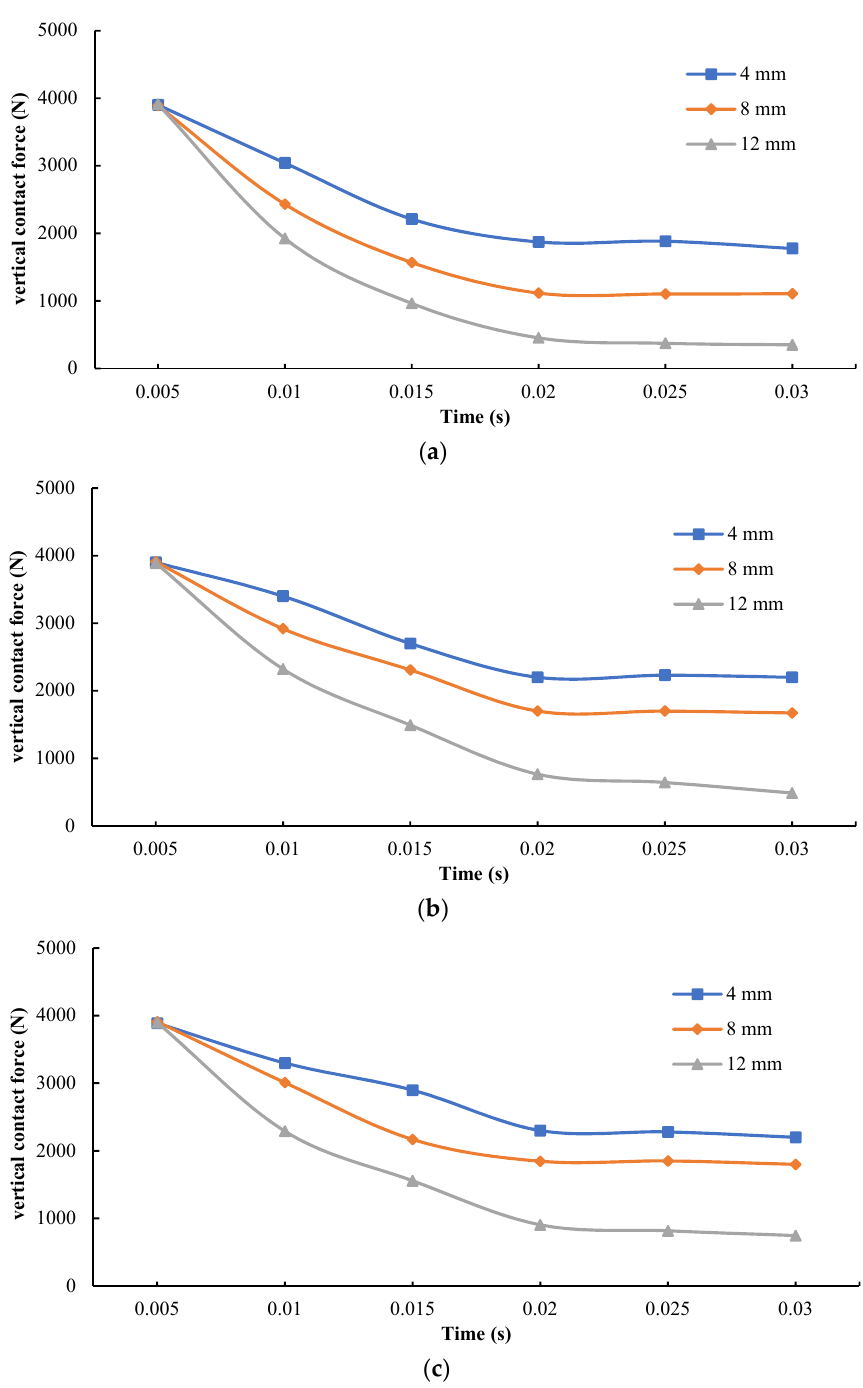
Figure 21. Effects of the thickness of water film on vertical contact force. ( a ) AC pavement; ( b ) SMA pavement; ( c ) OGFC pavement.